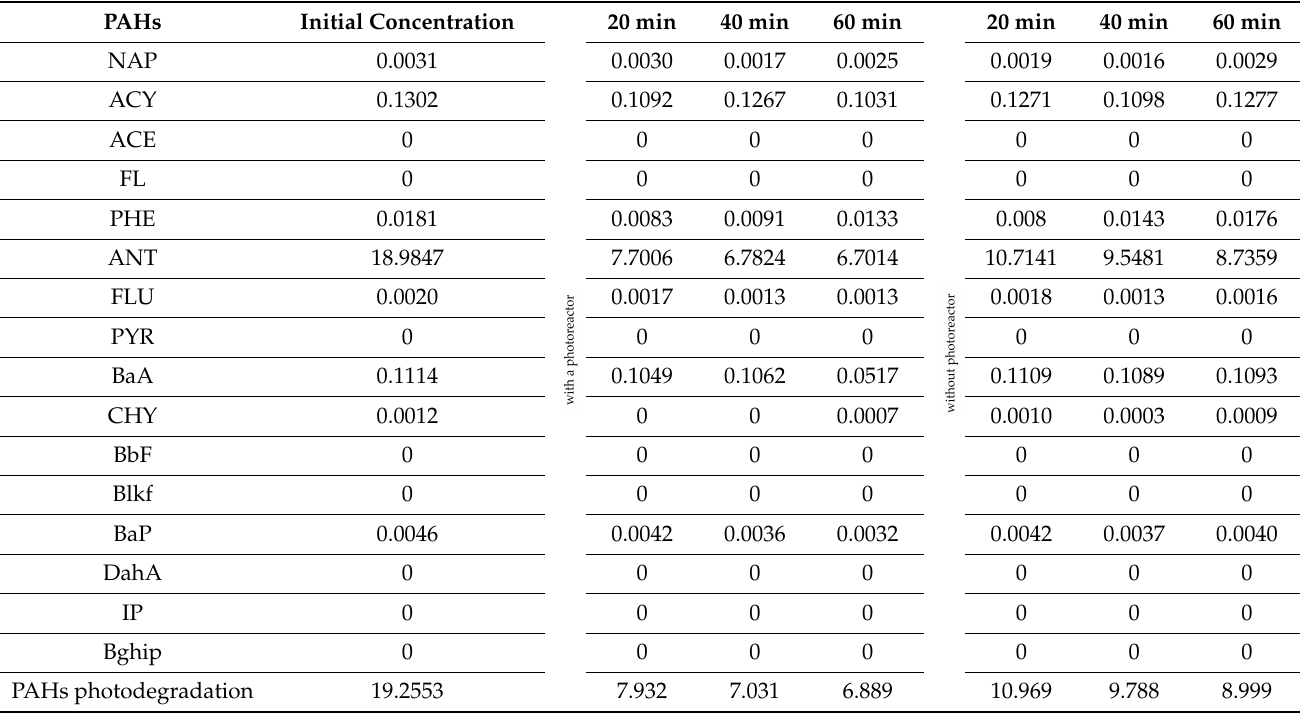
Table 3. Photodegradation of PAHs in acidic mine drainage (concentrations in mg/L).